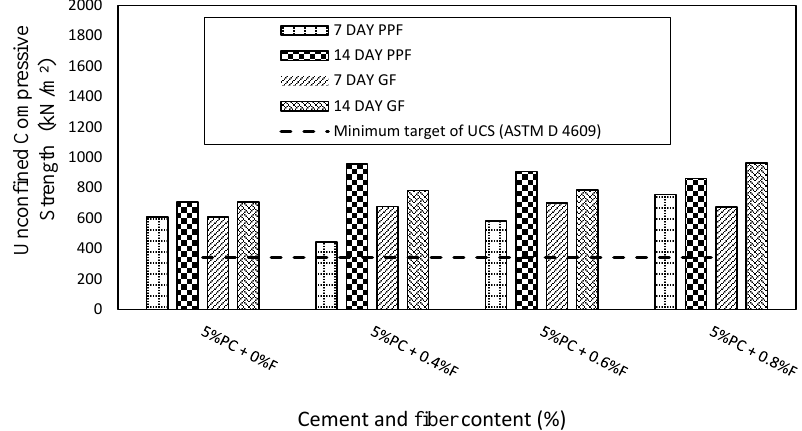
Figure 2. Unconfined compressive strength (UCS) test results for 5%PC and fibre for 7 and 14 days of curing .